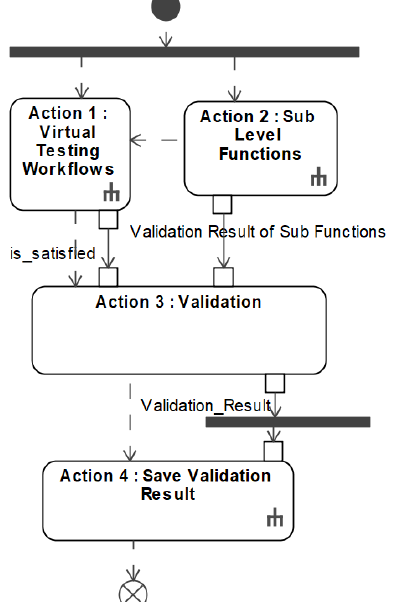
Figure 3. A virtual validation workflow framework.